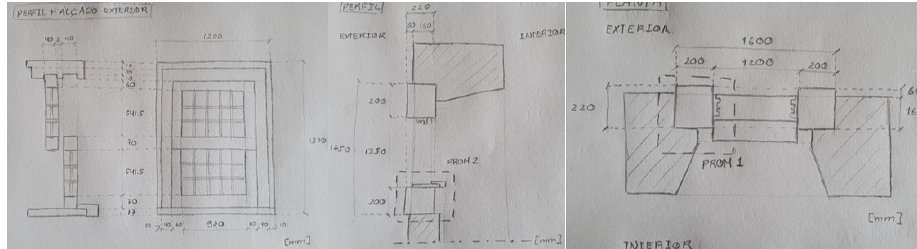
Figure 9. Sketches of a guillotine window made in the building.